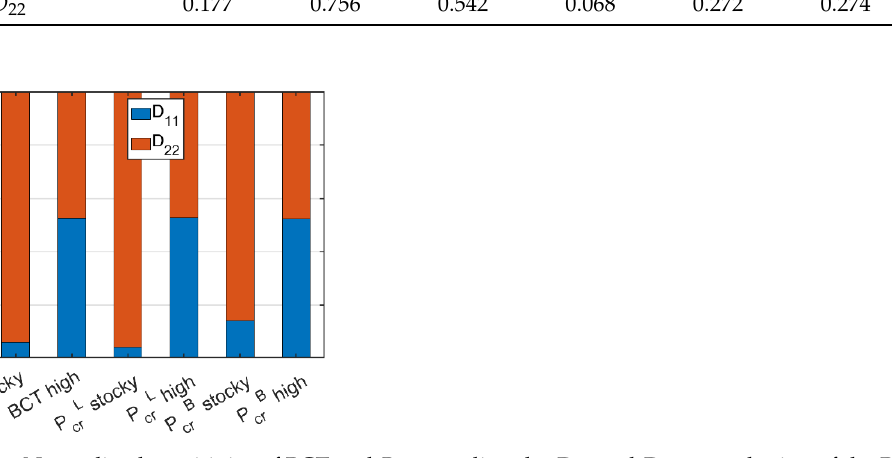
Figure 8. Normalized sensitivity of BCT and P cr regarding the D 11 and D 22 perturbation of the BC corrugated cardboard with a grade of 100-160-100-160-100.